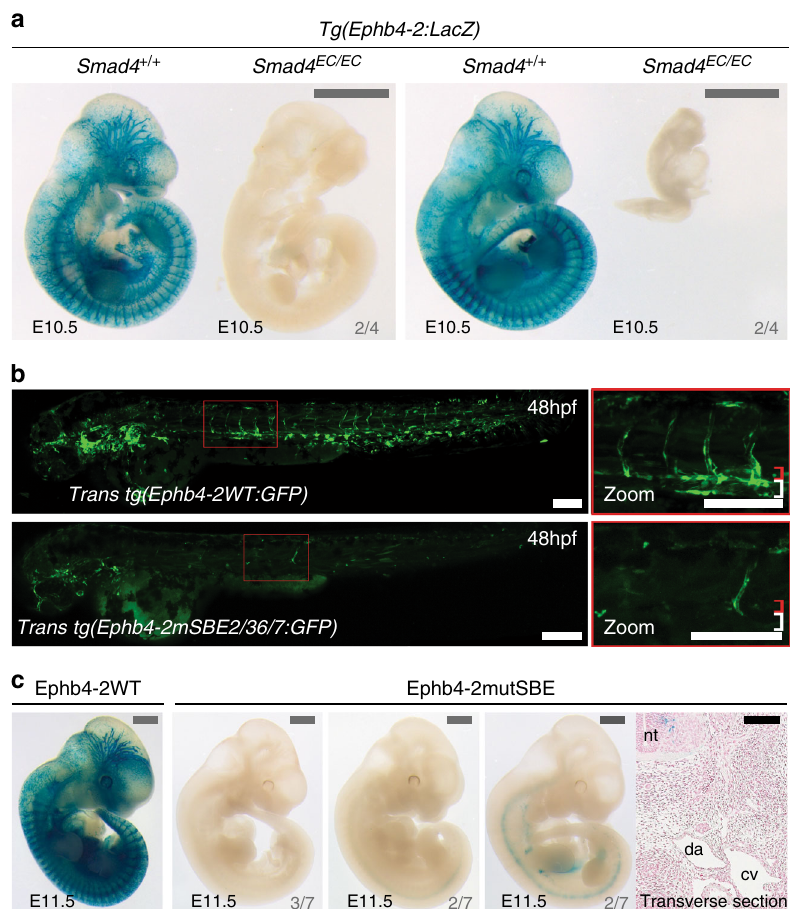
Fig. 5 Activity of the Ephb4-2 enhancer requires SMAD4. a Two sets of E10.5 Smad4 + / + ; Ephb4-2:LacZ and Smad4 EC/EC ; Ephb4-2:LacZ littermates demonstrates loss of Ephb4-2 enhancer activity after loss of SMAD4 regardless of extent of growth retardation ( n = 4 from 4 litters). Although some embryos exhibited severe growth retardation, similar sized younger embryos had robust Ephb4-2: LacZ expression (see Supplementary Fig. 5). Grey scale bars are 1000 μ m. b , c Mutation of two composite SMAD-binding elements (SBE2/3 and SBE6/7) within the Ephb4-2 enhancer resulted in near-total loss of enhancer activity compared to wild-type enhancer in F0 transgenic zebra fi sh ( b , mosaic due to nature of Tol2-mediated F0 transgenesis) and mice ( c ). Transverse section taken through the strongest lacZ -expressing F0 Ephb4-2mutSBE(2/3,6/7) embryo con fi rmed lack of vascular expression. Grey numbers in bottom right corner indicate the number of F0 mouse with similar expression patterns to the image shown. White and black scale bars both represent 100 μ m, grey scale bars are 1000 μ m. da = dorsal aorta, cv = cardinal vein, nt = neural tube; red bracket = dorsal artery; white bracket =